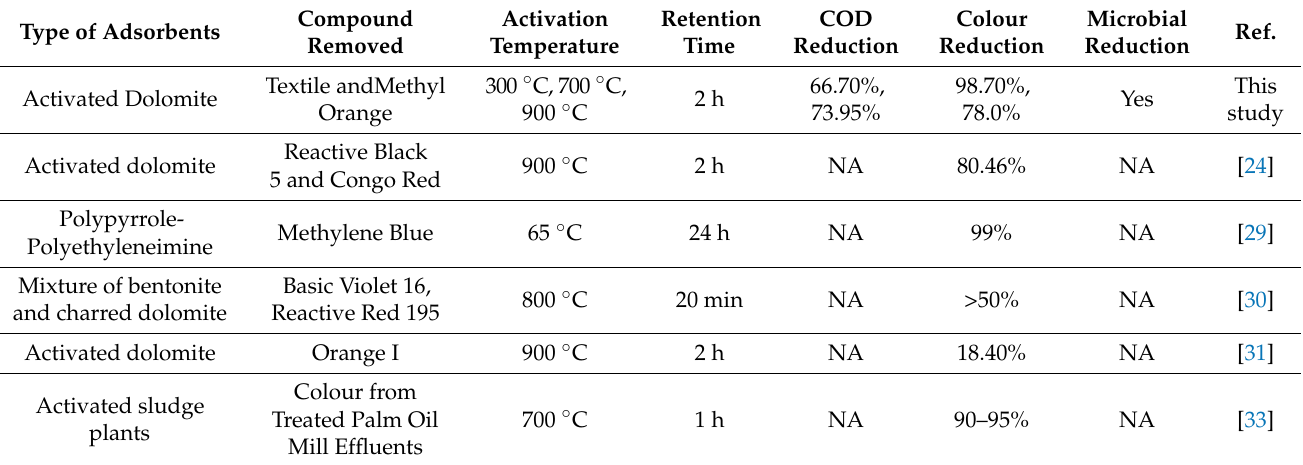
Table 6. Comparison of current works on adsorption of dye using activated dolomite and other